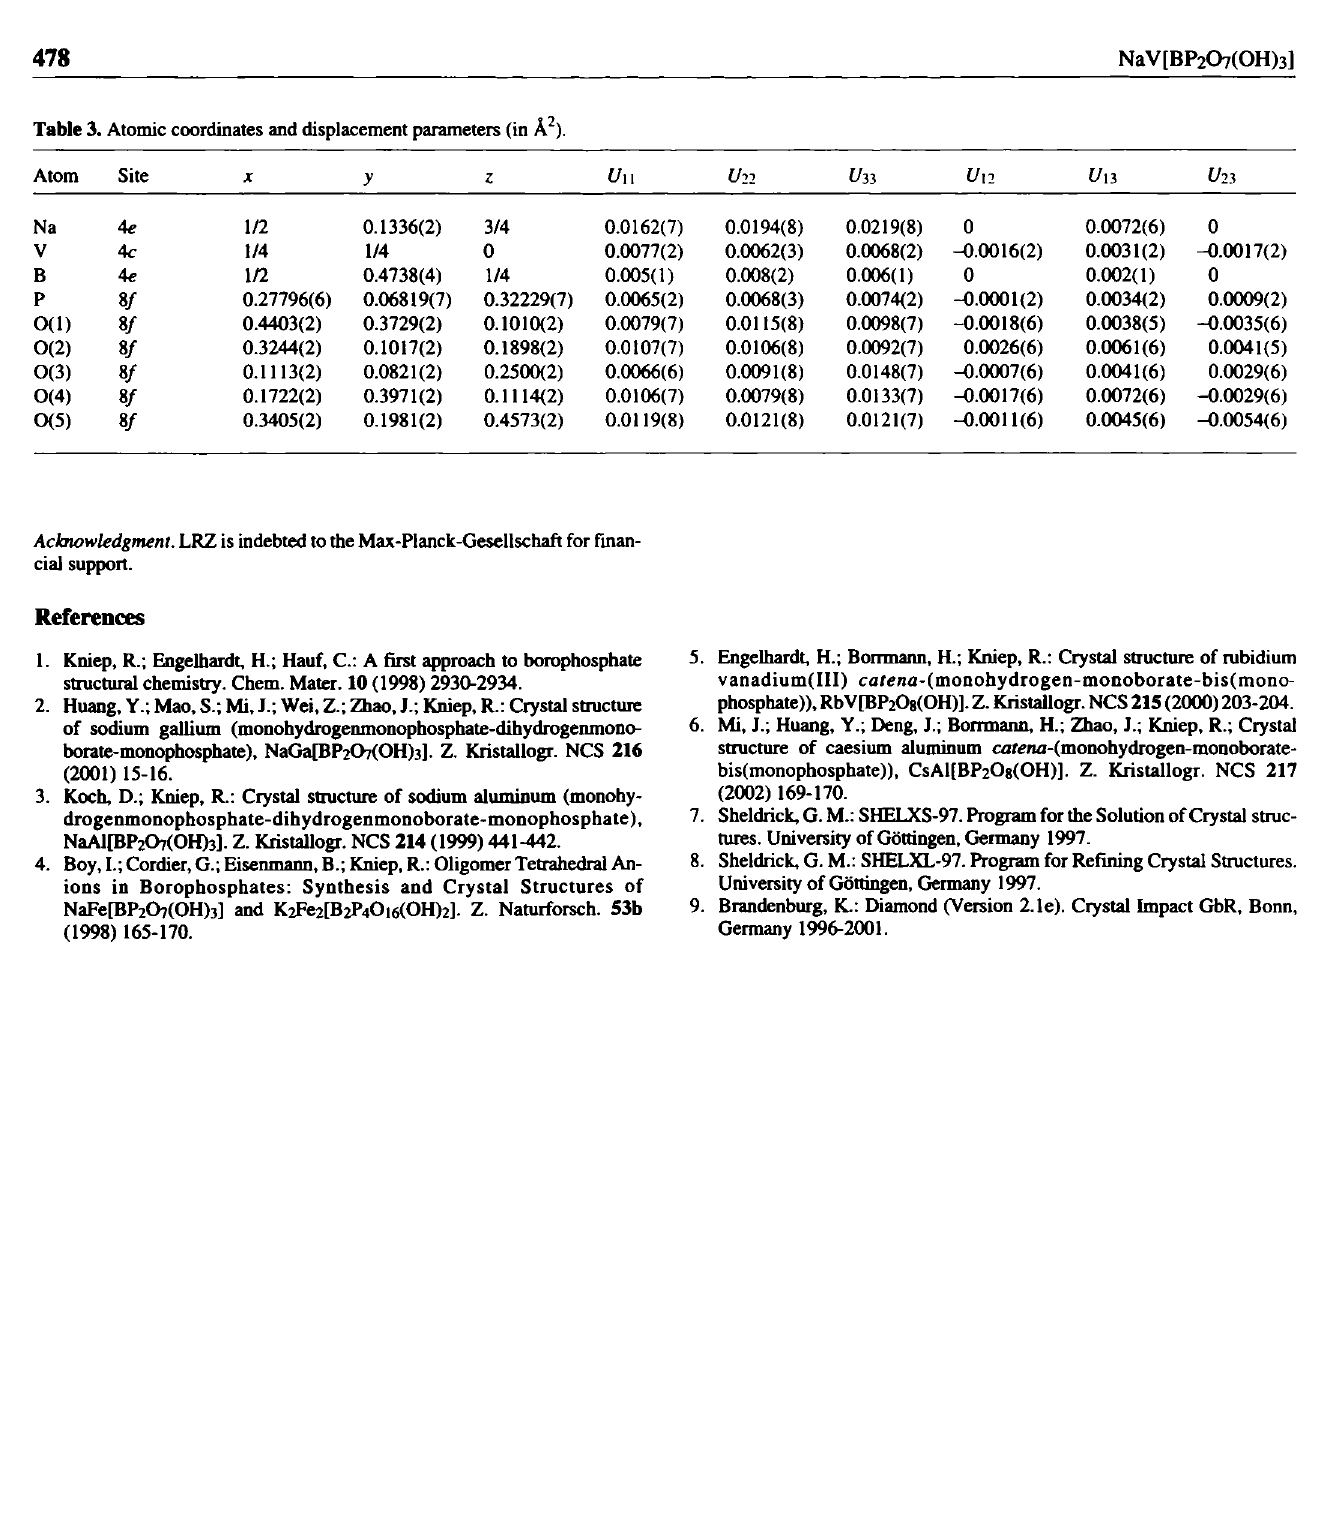
Table 3. Atomic coordinates and displacement parameters (in Â 2